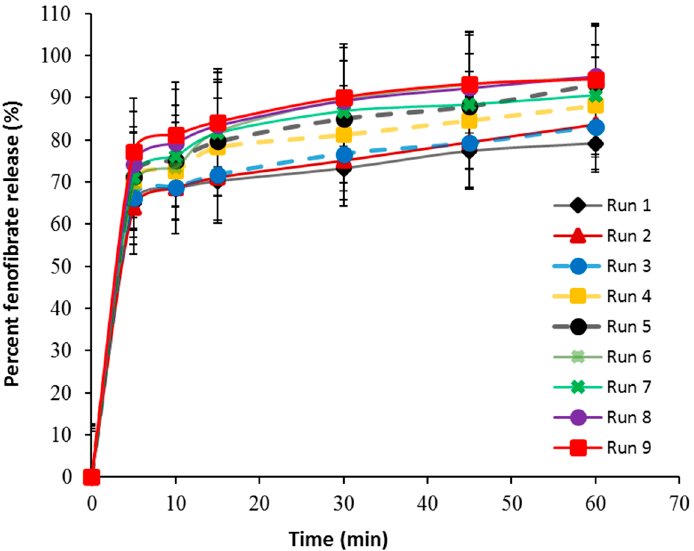
Figure 3. In vitro release profiles of fenofibrate tablets based on 3 2 full-factorial Design.